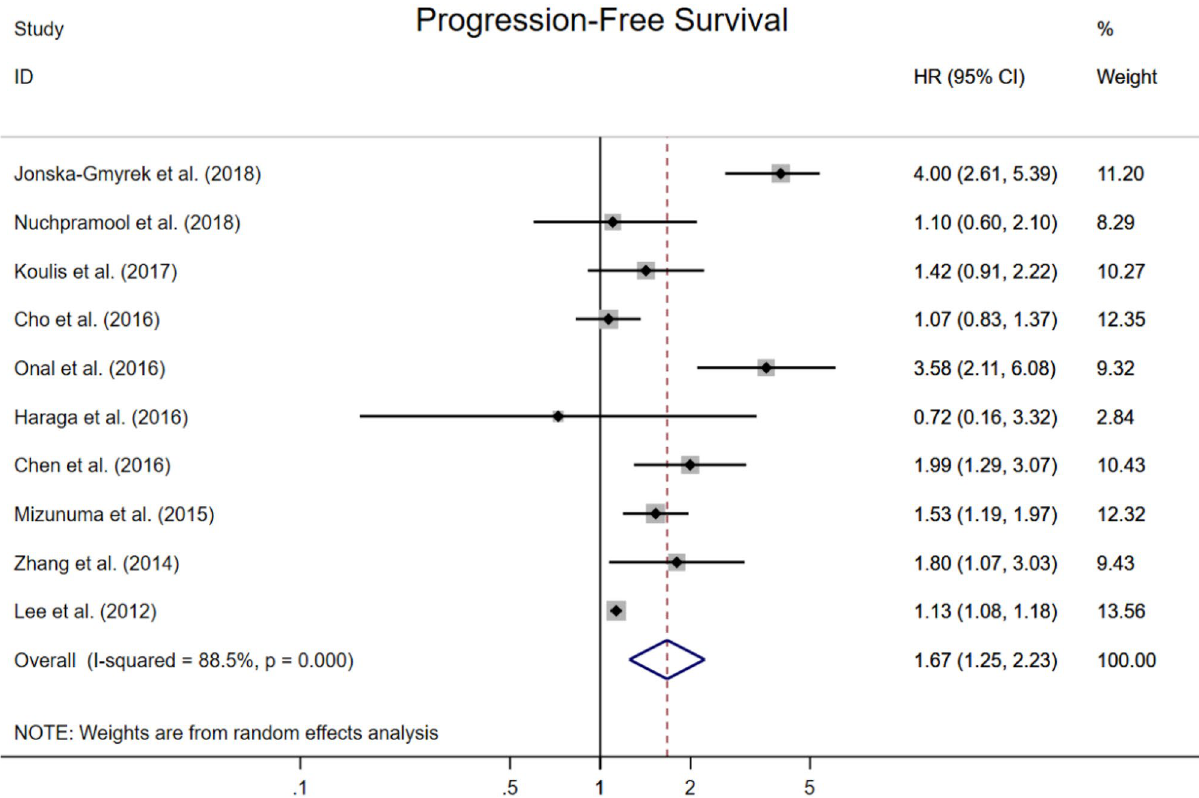
Figure 6. Forest plots showing hazard ratio for progression-free survival in all studies for neutrophil-to- lymphocyte